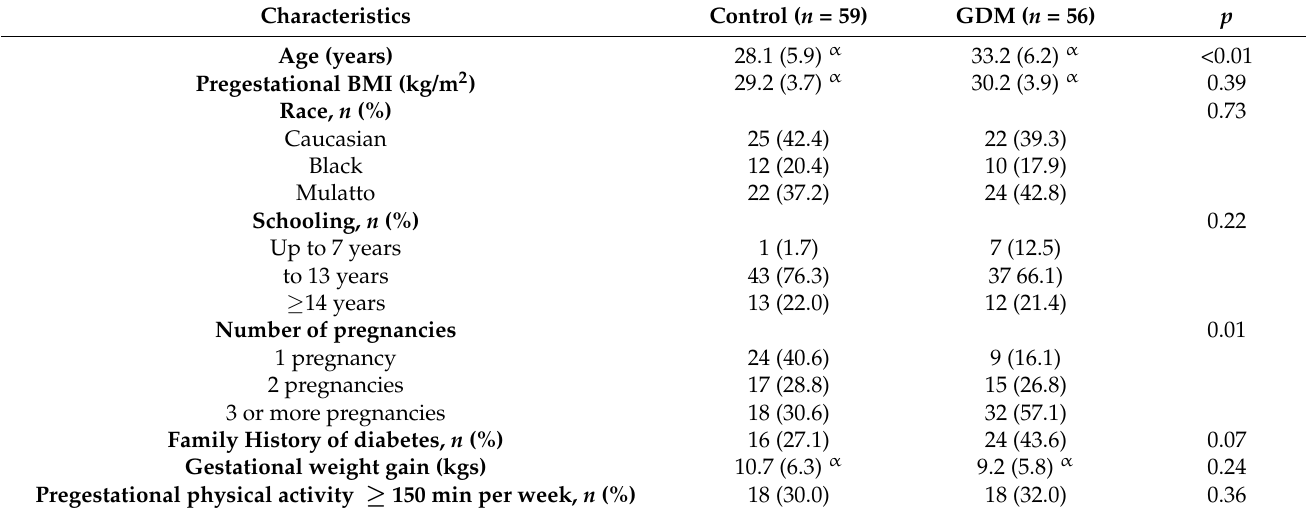
Table 1. Baseline characteristics of pregnant women with or without